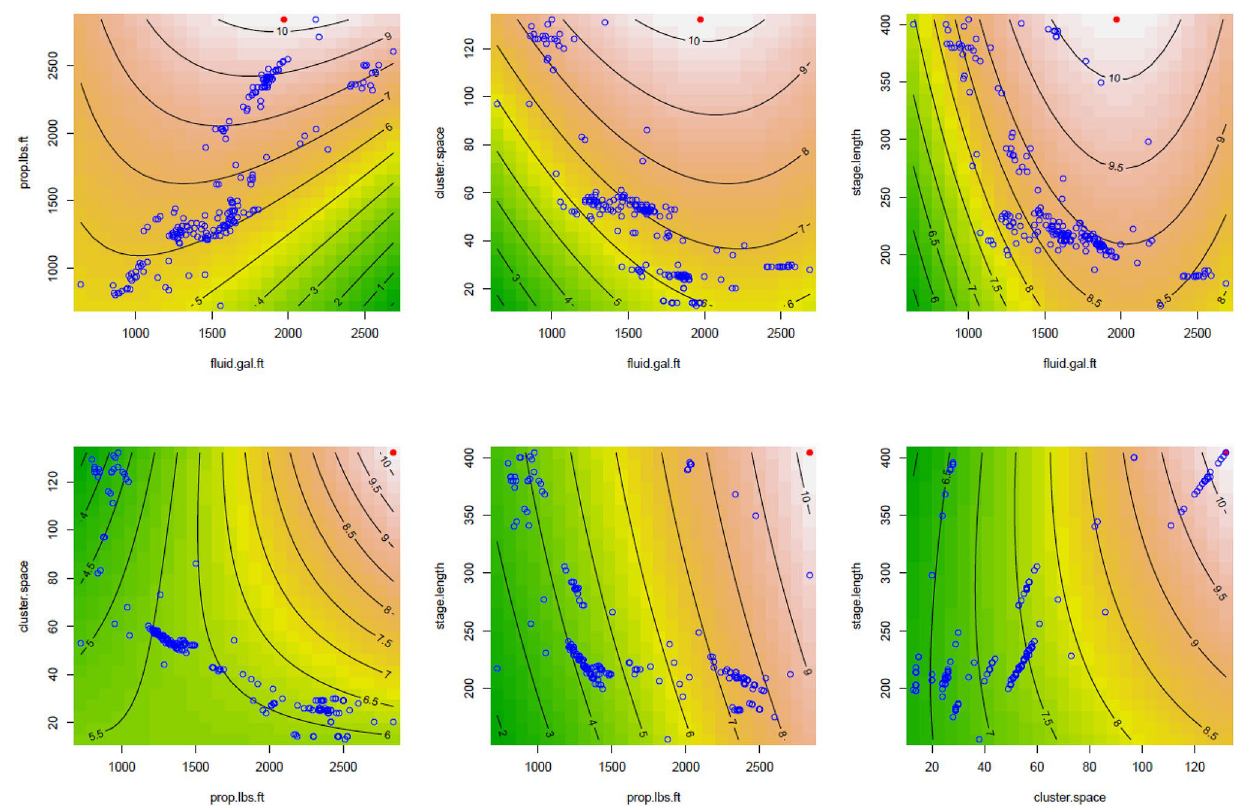
Fig. 5 Contour plots of log (IP 180) versus 2D-slice of various input